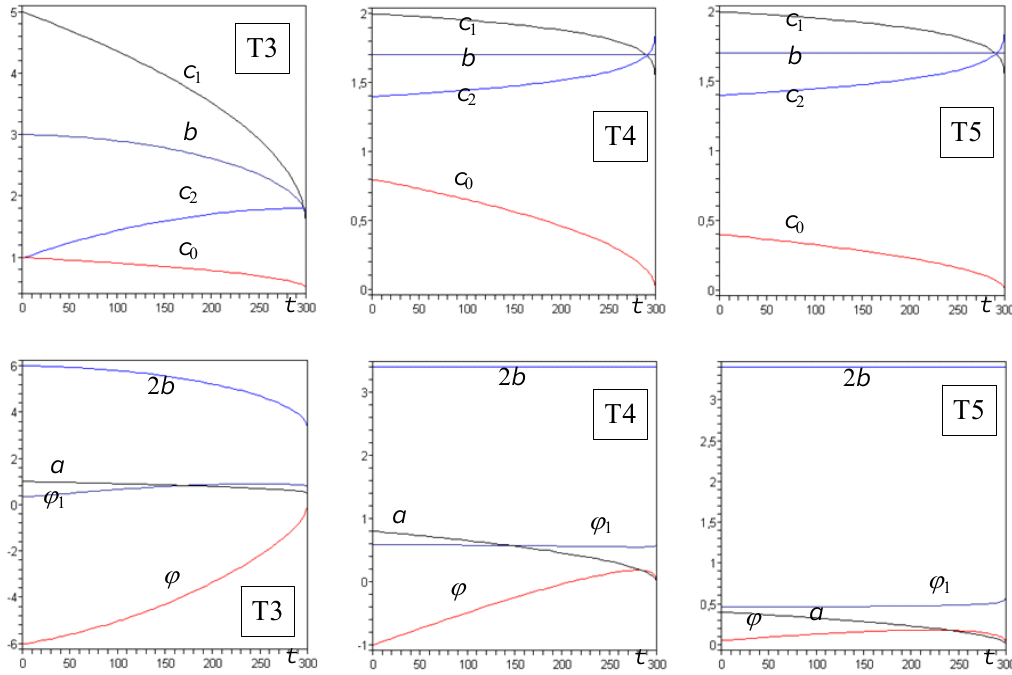
Figure 3. Time-domain trajectories of parameters c T3, T4 and